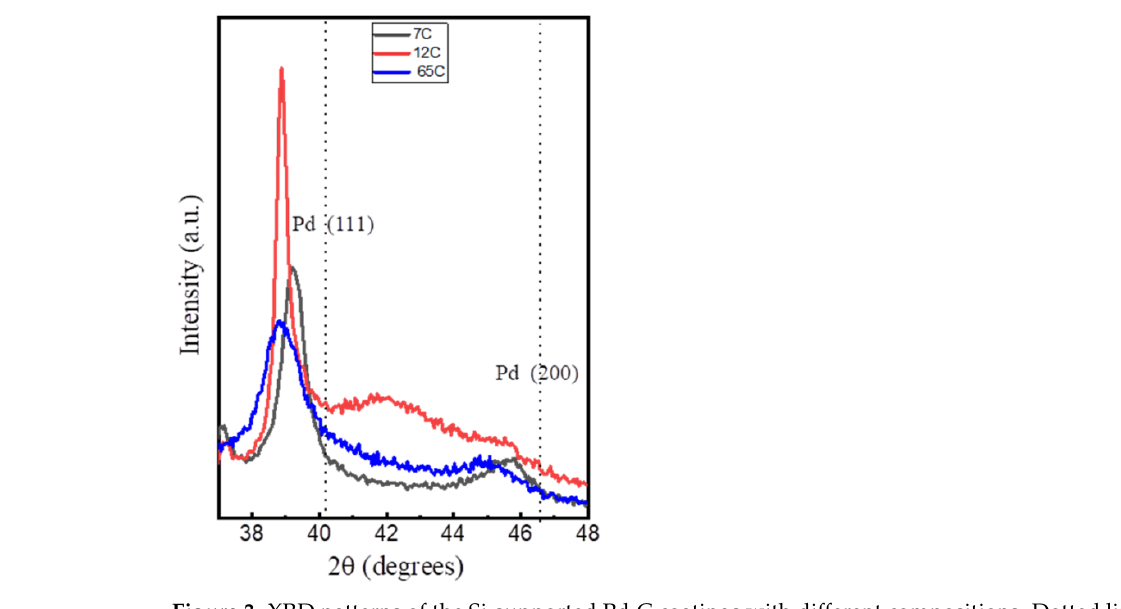
Figure 3. XRD patterns of the Si-supported Pd-C coatings with different compositions. Dotted lines indicate the position of pure Pd peaks.